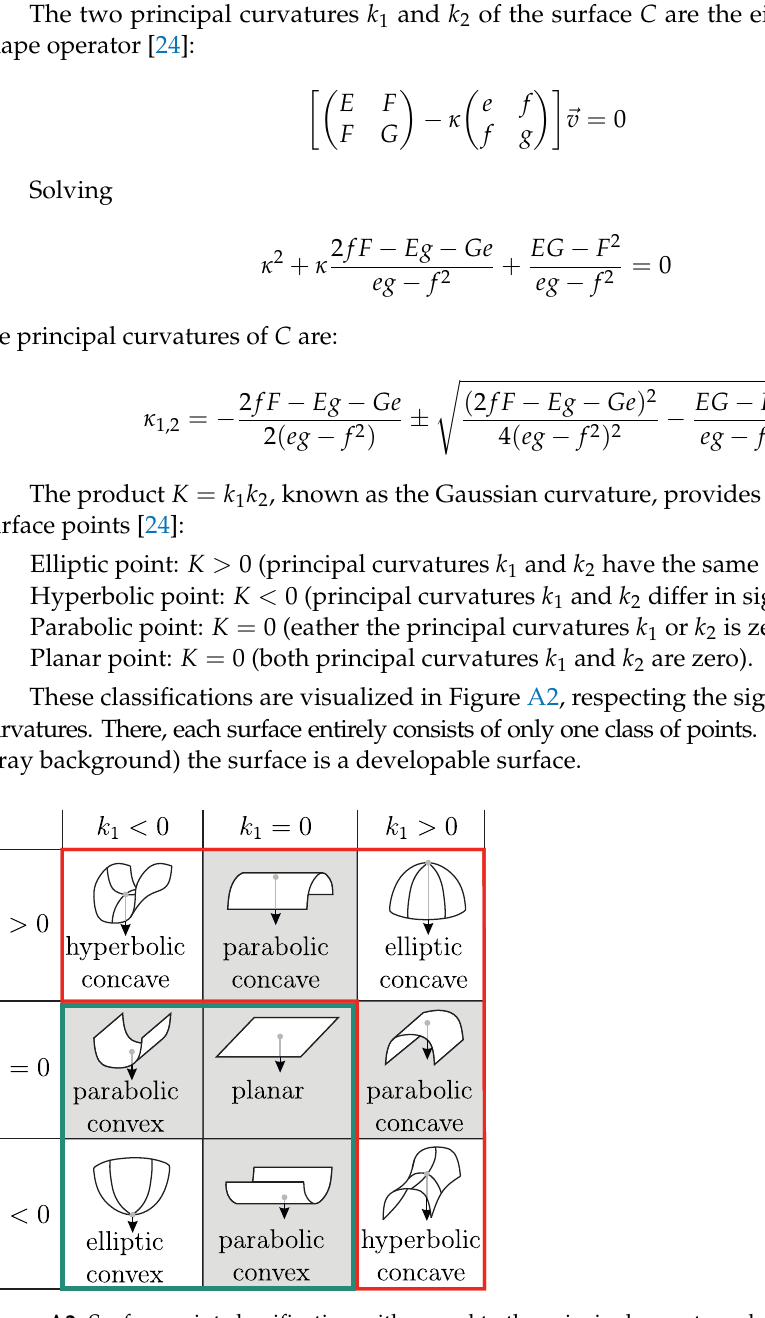
Figure A2. Surface point classification with regard to the principal curvatures based on